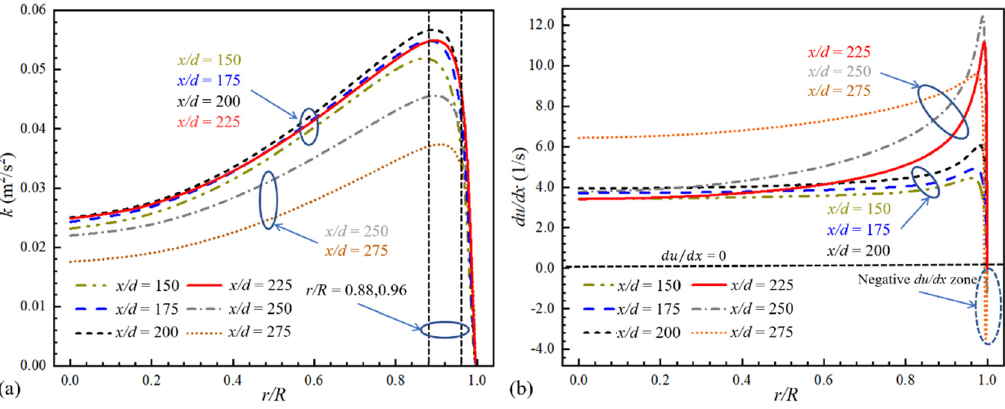
Figure 8. Flow parameters of n -decane along the flow direction: ( a ) radial distributions of turbulent kinetic energy; ( b ) radial distributions of axial velocity gradient.